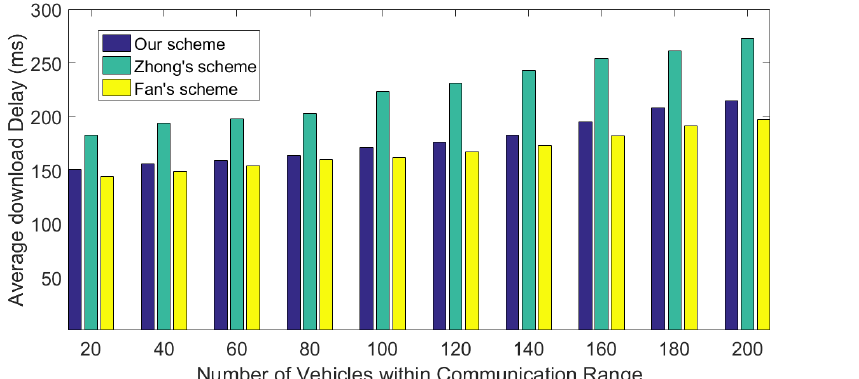
Figure 8. Download data